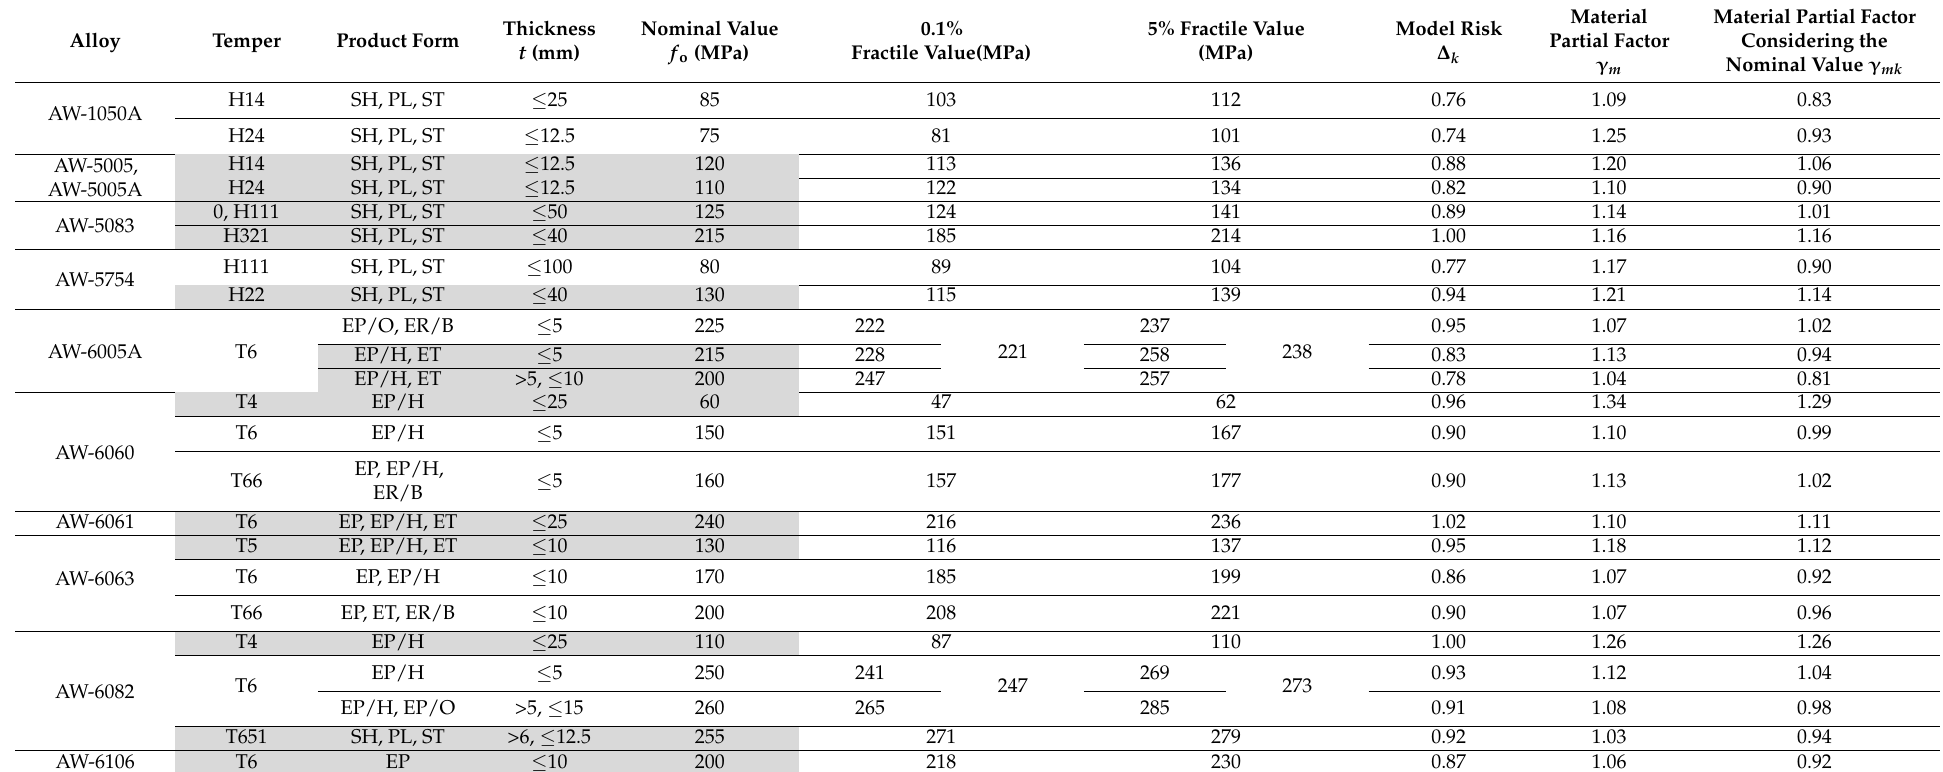
Table 3. Material partial factor determination for 0.2% proof